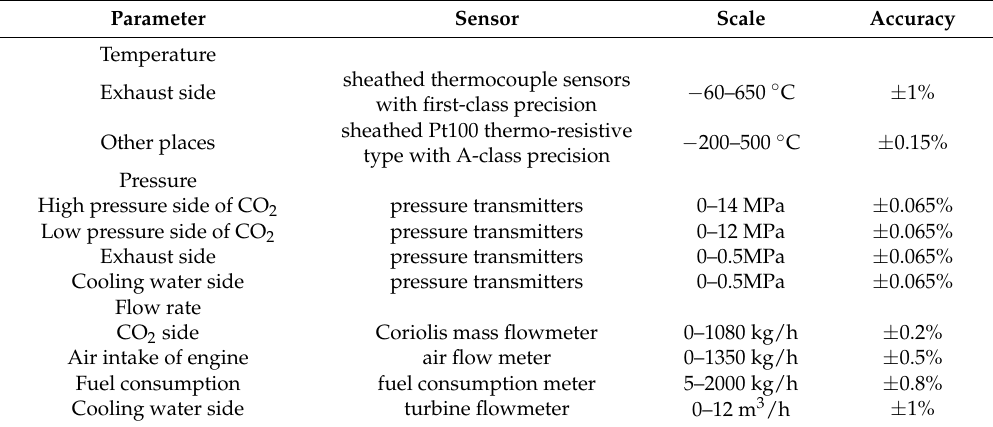
Table 2. Measuring instruments and accuracy of the main